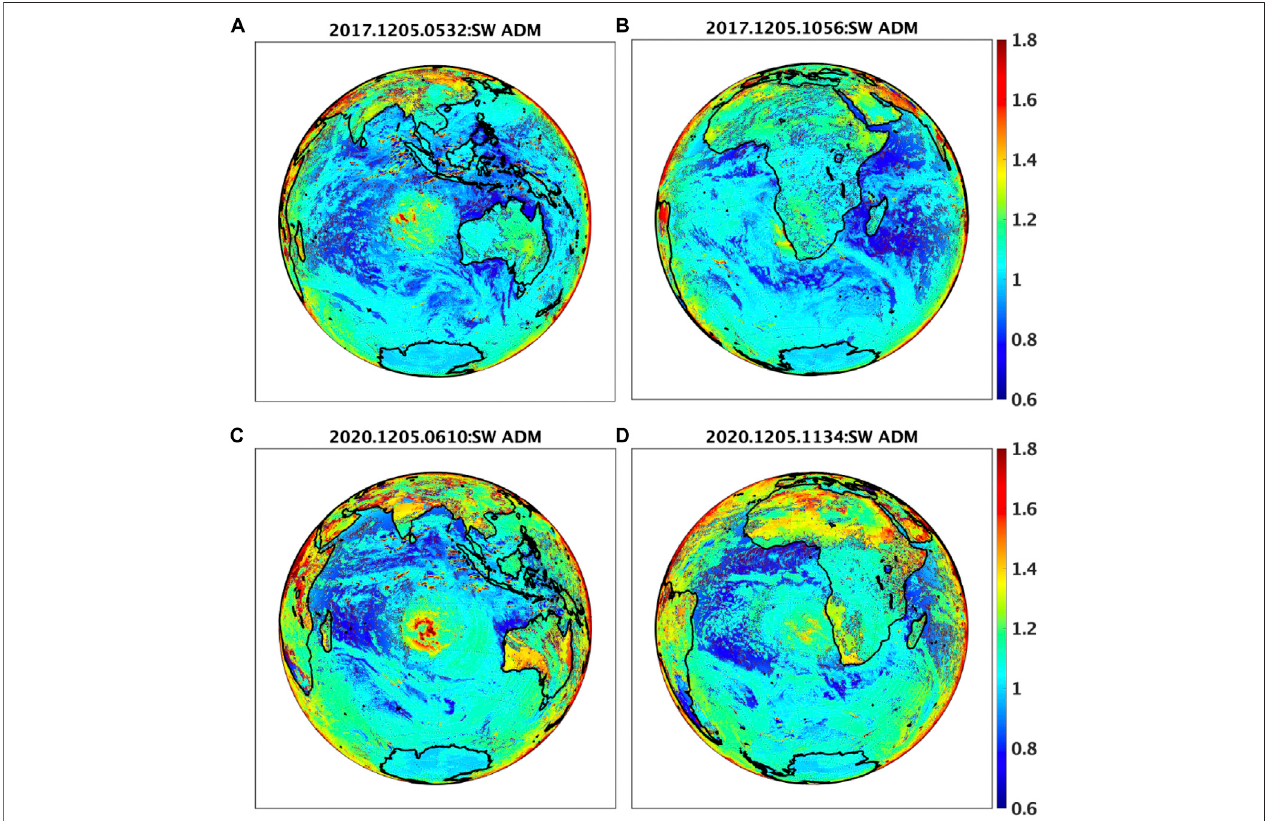
FIGURE 9 | Anisotropic factors at the EPIC pixel level for December 5, 2017 (top row) at image time of 05:32 UTC (A) , and 10:56 UTC (B) , and for December 5, 2020 (bottom row) at image time of 06:10 UTC (C) , and 11:34 UTC (D) .